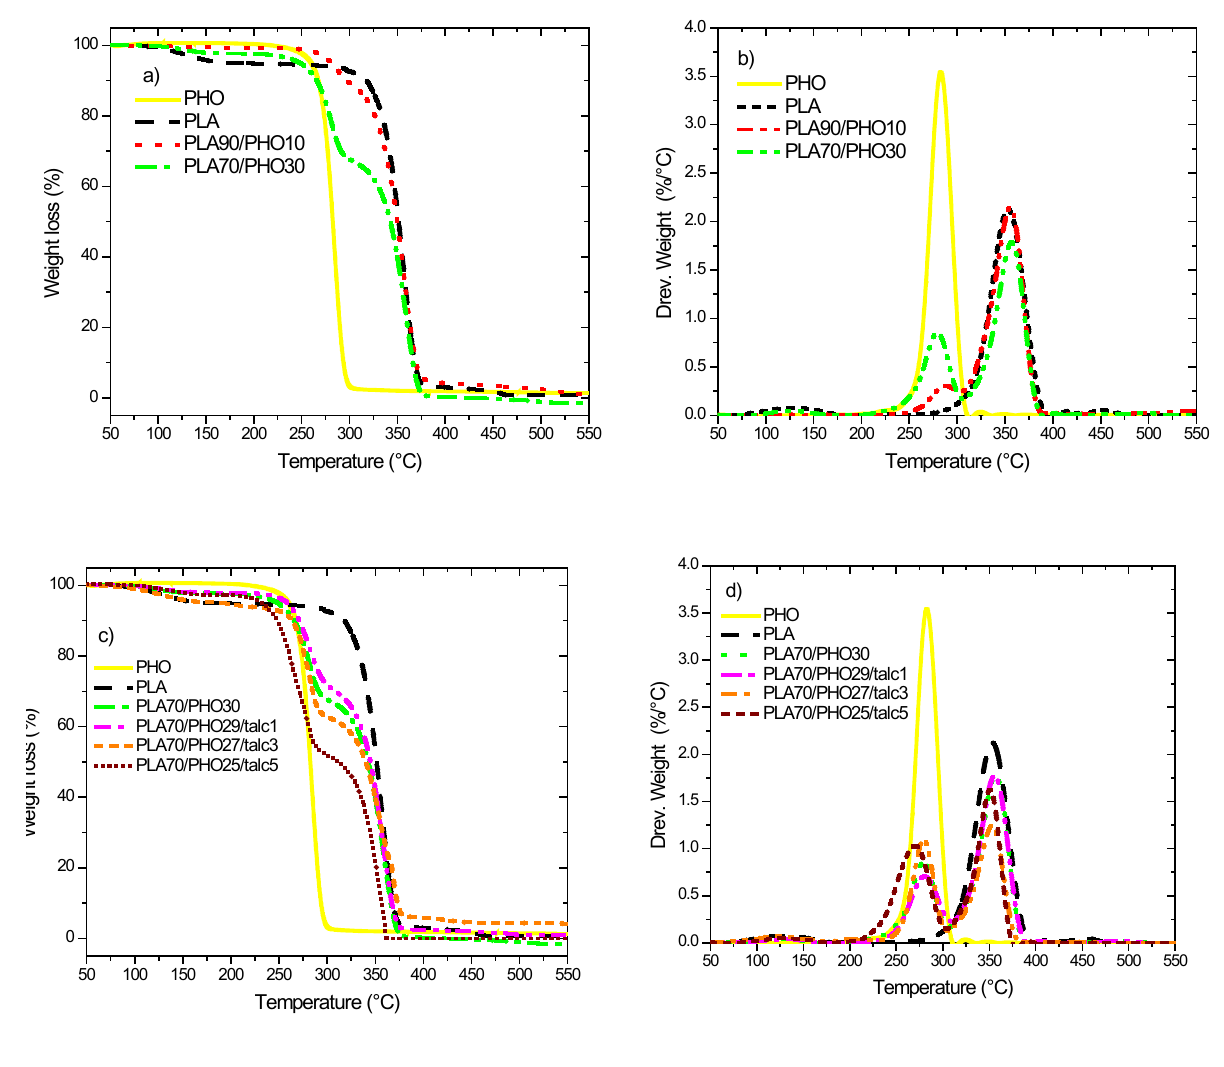
Figure 7: TG & DTG thermograms for PLA, PHO and their blends. Table 5: TGA analysis of PHO, PLA and their blends.